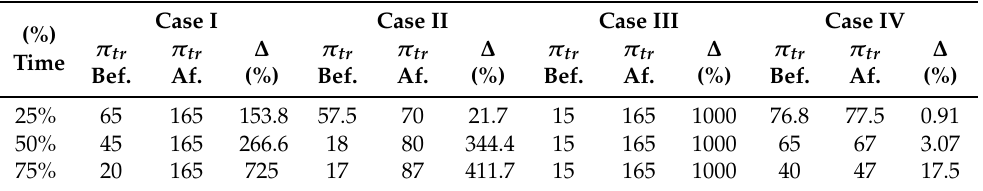
Table 4. Effect on the transaction prices (EUR/MWh) for information of 100 % outage of Wind 1 at different trading times and for different pricing strategies. (First column: Share of trading horizon reached at outage in %) (Bef.: Before, Af.: